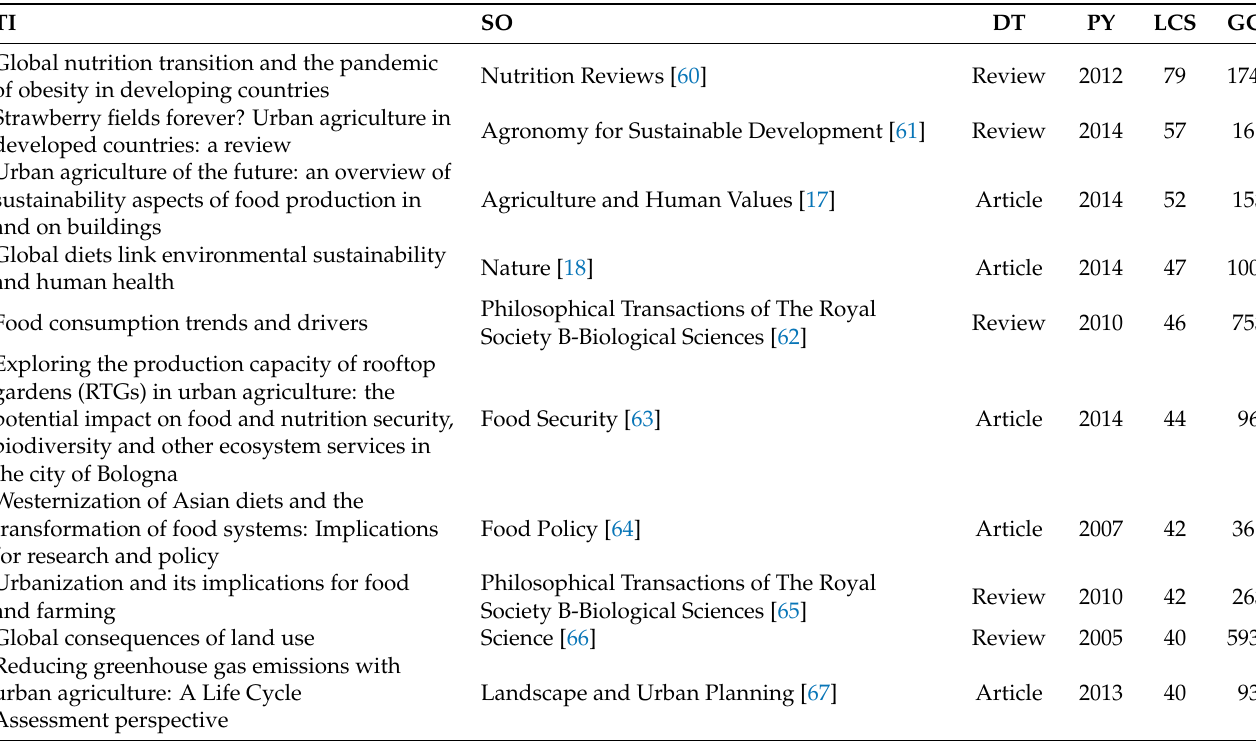
Table 4. Top 20 local cited references from